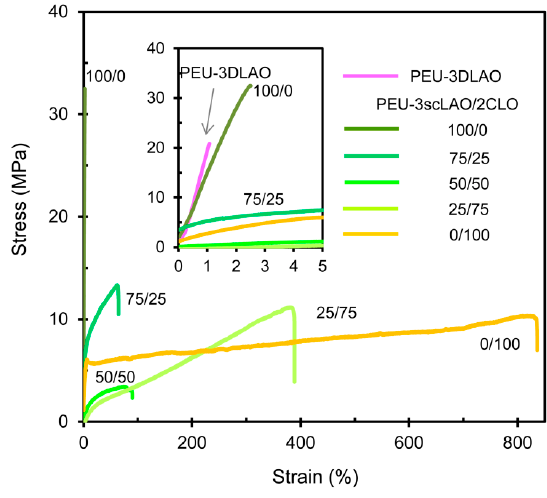
Figure 9. Stress-strain curves of PEU-3scLAO/2CLOs (100/0, 75/25, 50/50, 25/75 and 0/100).